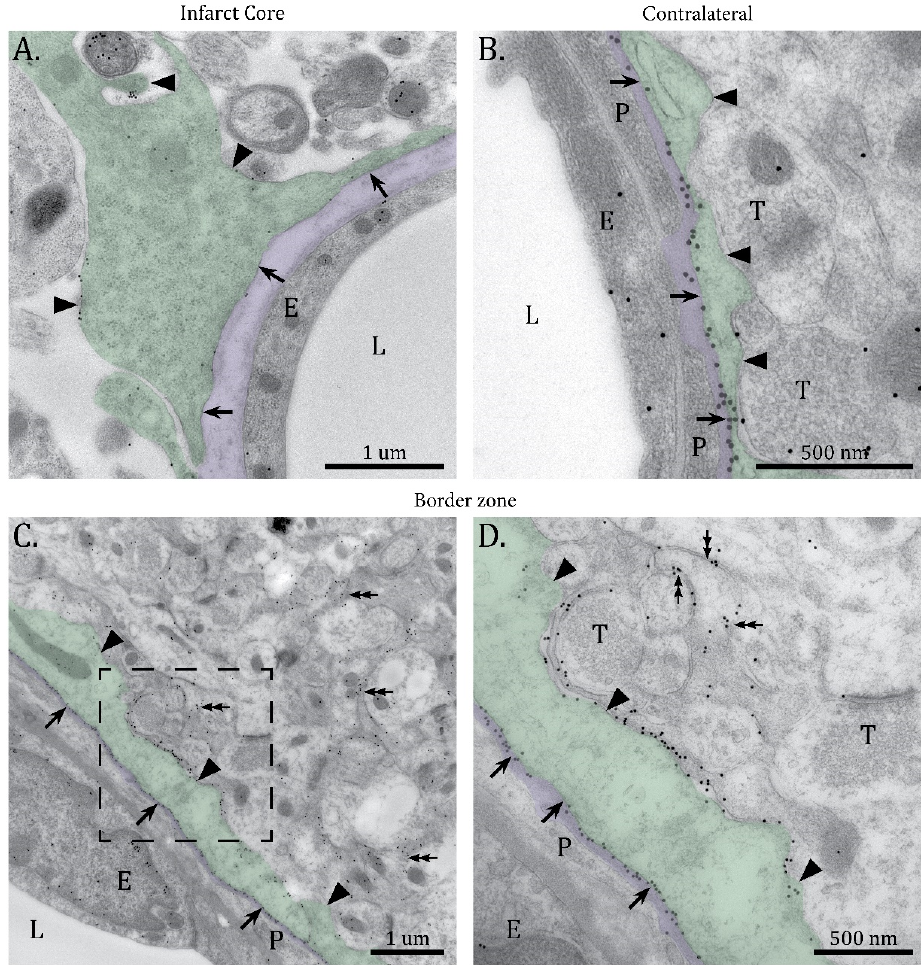
Figure 2. Loss of polarized expression of AQP4 in the border zone. High resolution electron micro- scopic images showing AQP4 immunogold labeling in the infarct core ( A ), cortex contralateral to the infarct ( B ) and border zone of the infarct ( C , D ). ( A ) The perivascular astrocyte endfoot is detached from the subendothelial basal lamina, which seems disintegrated. The astrocyte process is swollen and faint AQP4 immunogold labeling is evenly distributed in the adluminal (arrows) and abluminal (arrowheads) membrane domains. The extracellular space is expanded. ( B ) Highly polarized local- ization of AQP4 in the adluminal membrane domain (arrows) of a perivascular astrocyte endfoot in the contralateral cortex. Only a few AQP4 immunogold particles are detected in the abluminal mem- brane domain of the perivascular astrocyte endfoot (arrowheads). ( C ) A hypertrophic perivascular astrocytic endfoot abutting a vessel in the border zone of the infarct. ( D ) High magnification of boxed area in ( C ) shows strong AQP4 immunogold labeling in both the adluminal (arrows) and abluminal (arrowheads) membrane domains of the hypertrophic astrocyte endfoot. Strong AQP4 labeling is also present in the thinner astrocyte processes in the neuropil (double-headed arrows). L; vessel lumen, E; endothelium, P; pericyte, T; axon terminals. Green tint indicates perivascular astrocytic endfeet and purple tint shows the subendothelial basal lamina. Scale bars ( A , C ) = 1 µ m; ( B , D ) = 500